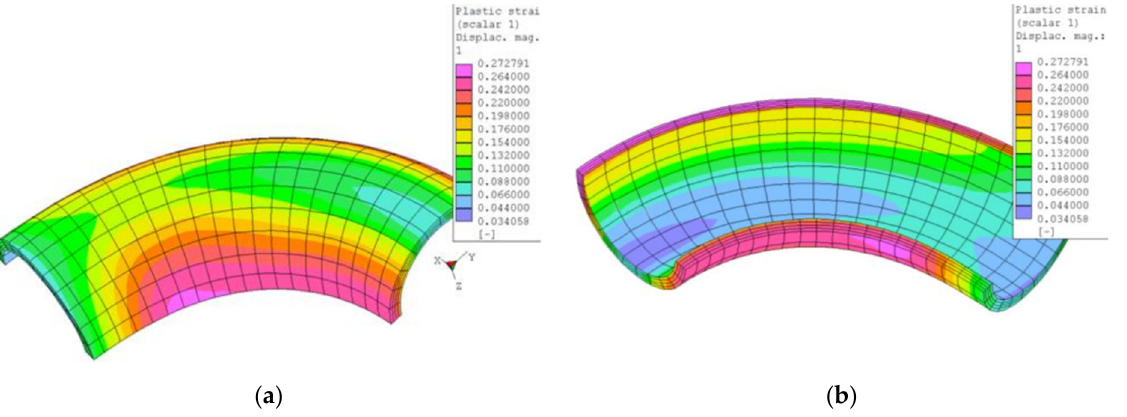
Figure 2. Isoplanes of plastic deformation after bending ( a ) outer and ( b ) inner views in the FEM PMD software.